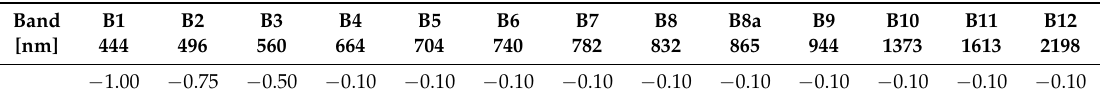
Table 1. Imaginary part of refractive index ( × 1000) of the standard continental aerosol type, for Sentinel-2A